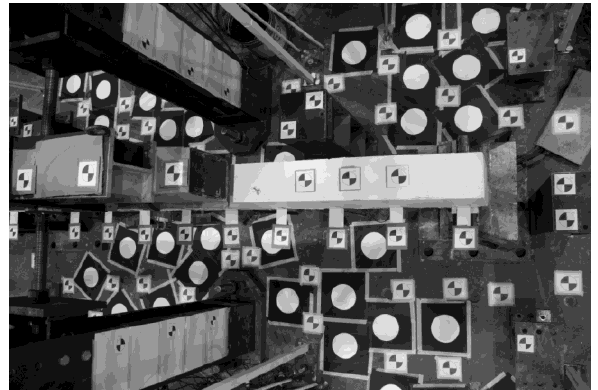
Figure 3. Distribution of physical signalized targets used for